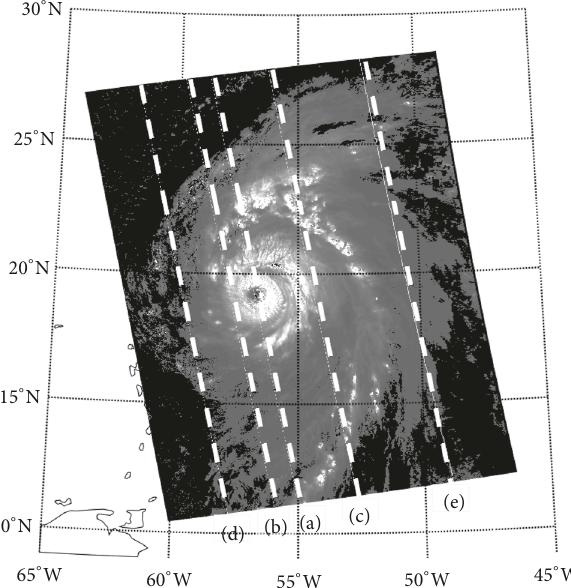
Figure 12: MODIS COT gray-scale image of TC Bill for the same domain presented in Figure 11. (a) CloudSat track. (b), (c), (d), (e) denote the selected scans away from the CloudSat track by 100 km, 200 km, 300 km, and 400 km, respectively.